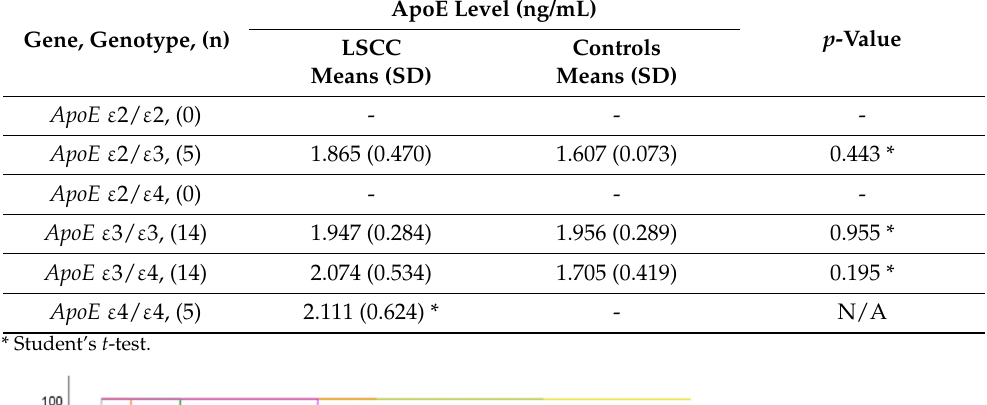
Table 12. Genotype distribution and serum ApoE levels.